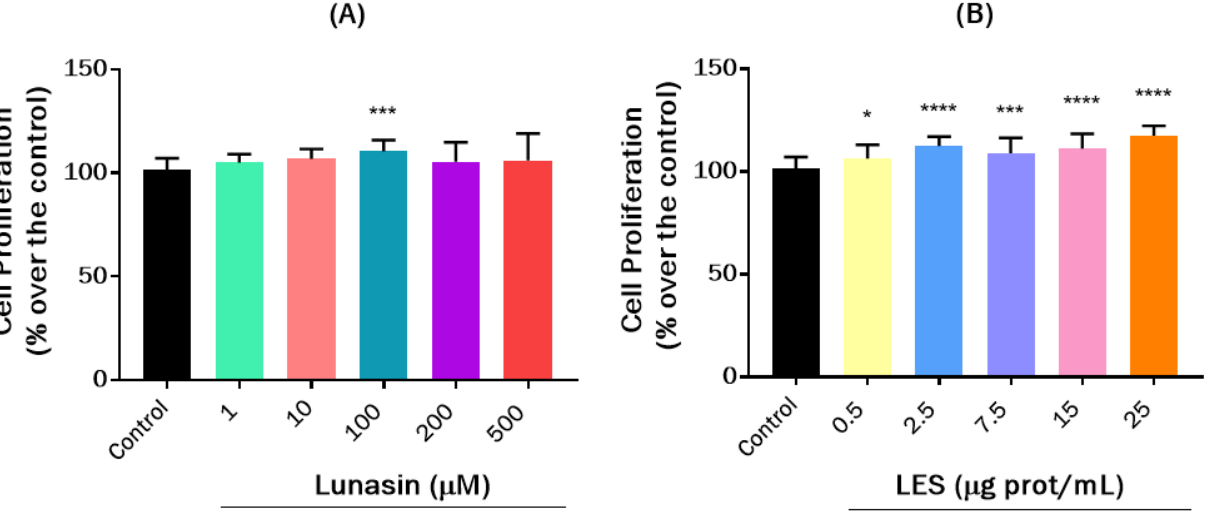
Figure 2. Effects of lunasin and lunasin-enriched soybean extract (LES) on the proliferation of EL4 cells. ( A ) Effects of synthetic lunasin (1–500 µ M) on the cell proliferation (% over the control) of EL-4 cells under basal conditions after 24 h of treatment. ( B ) Effects of LES (0.5–25 µ g protein/mL) on EL4 cell proliferation (% over the control) under basal conditions after 24 h of treatment. Significant differences compared to control: * p < 0.05; *** p < 0.001; **** p < 0.0001.